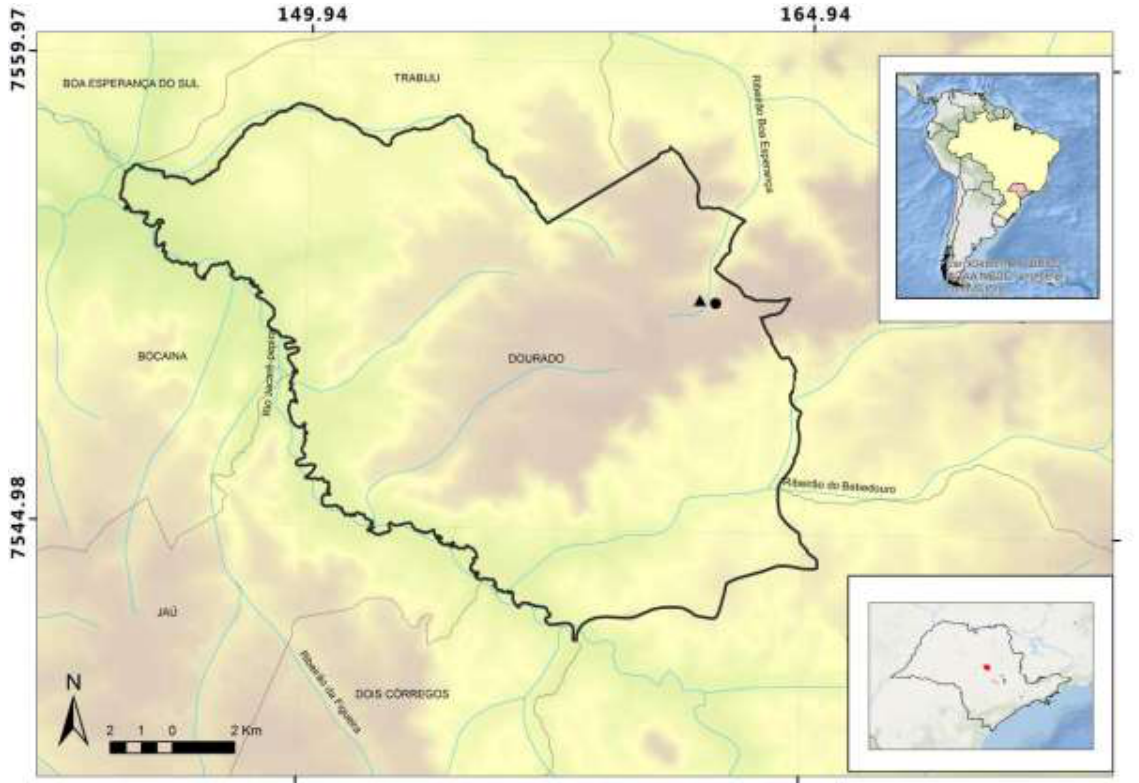
Figure 1. Location of the sites mentioned in the text, within Dourado Municipality, central São Paulo state, southeastern Brazil. Black triangle: Picão site; Black circle: Bastos site. Coordinates are in